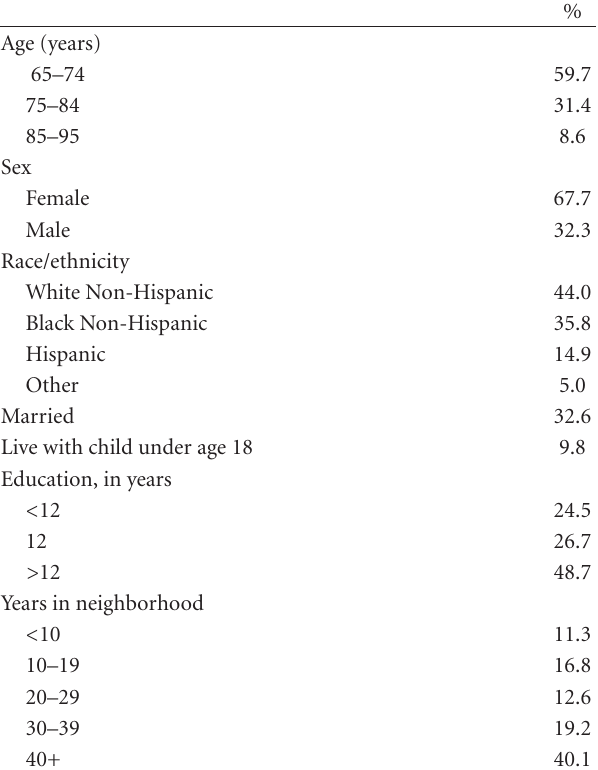
Table 1: Descriptive